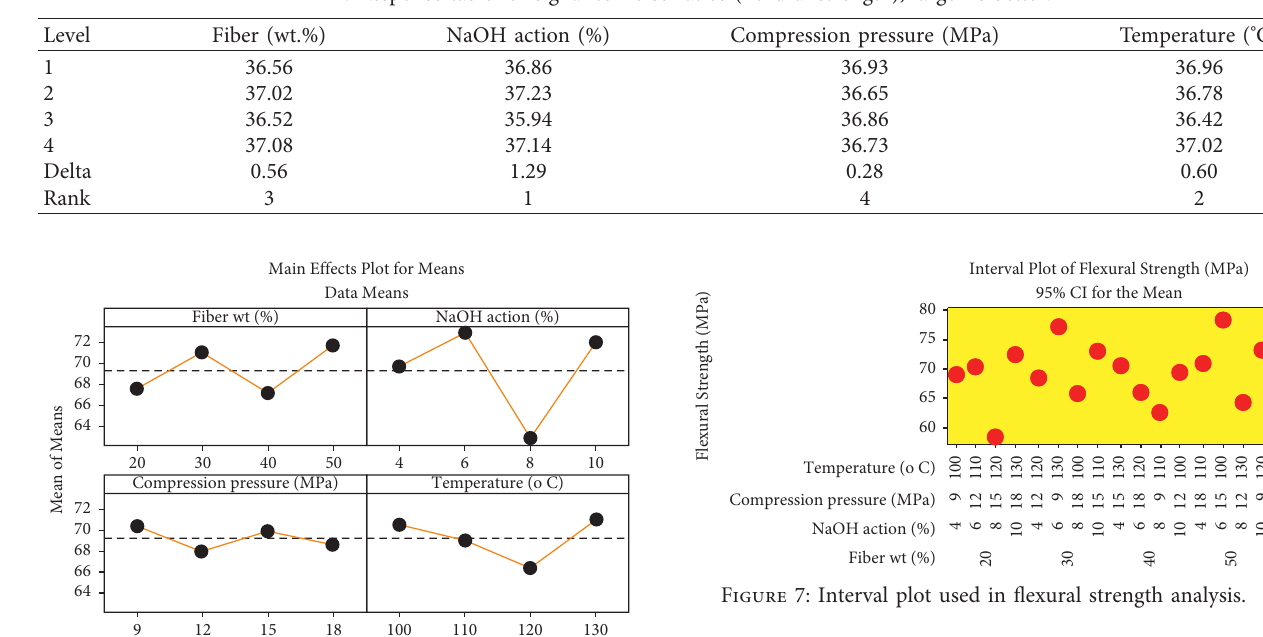
Table 4: Response table for signal-to-noise ratios (flexural strength); larger is better.